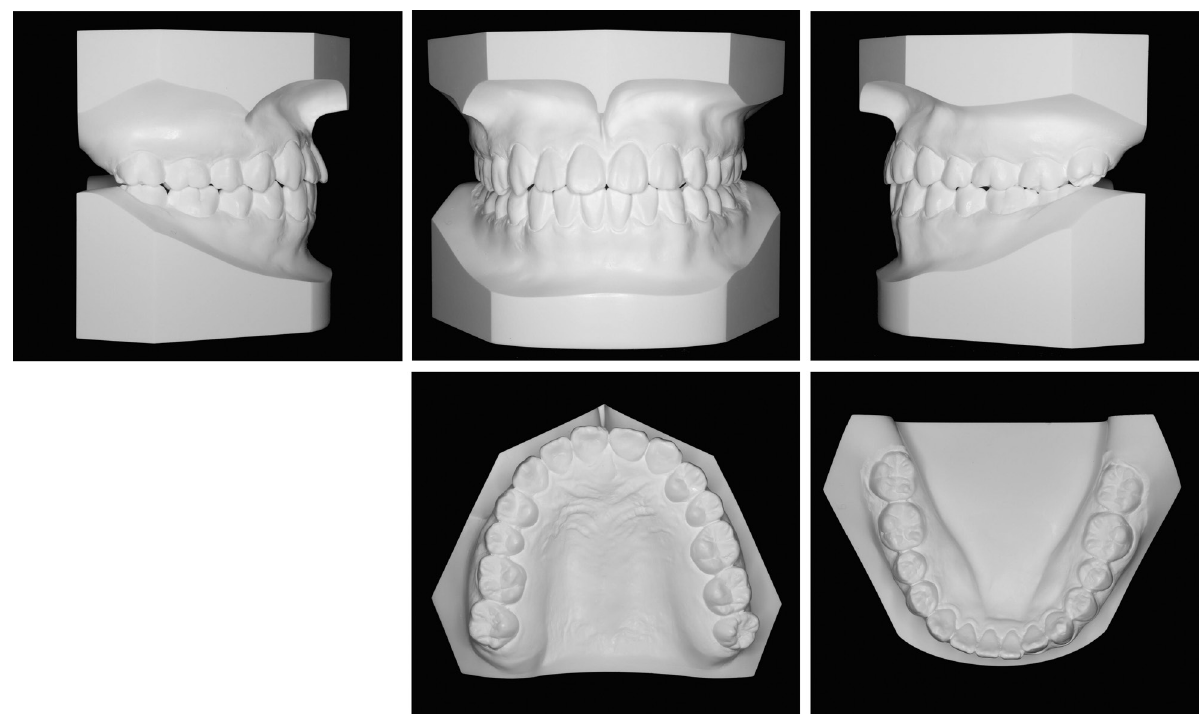
Figure 13. Postretention dental